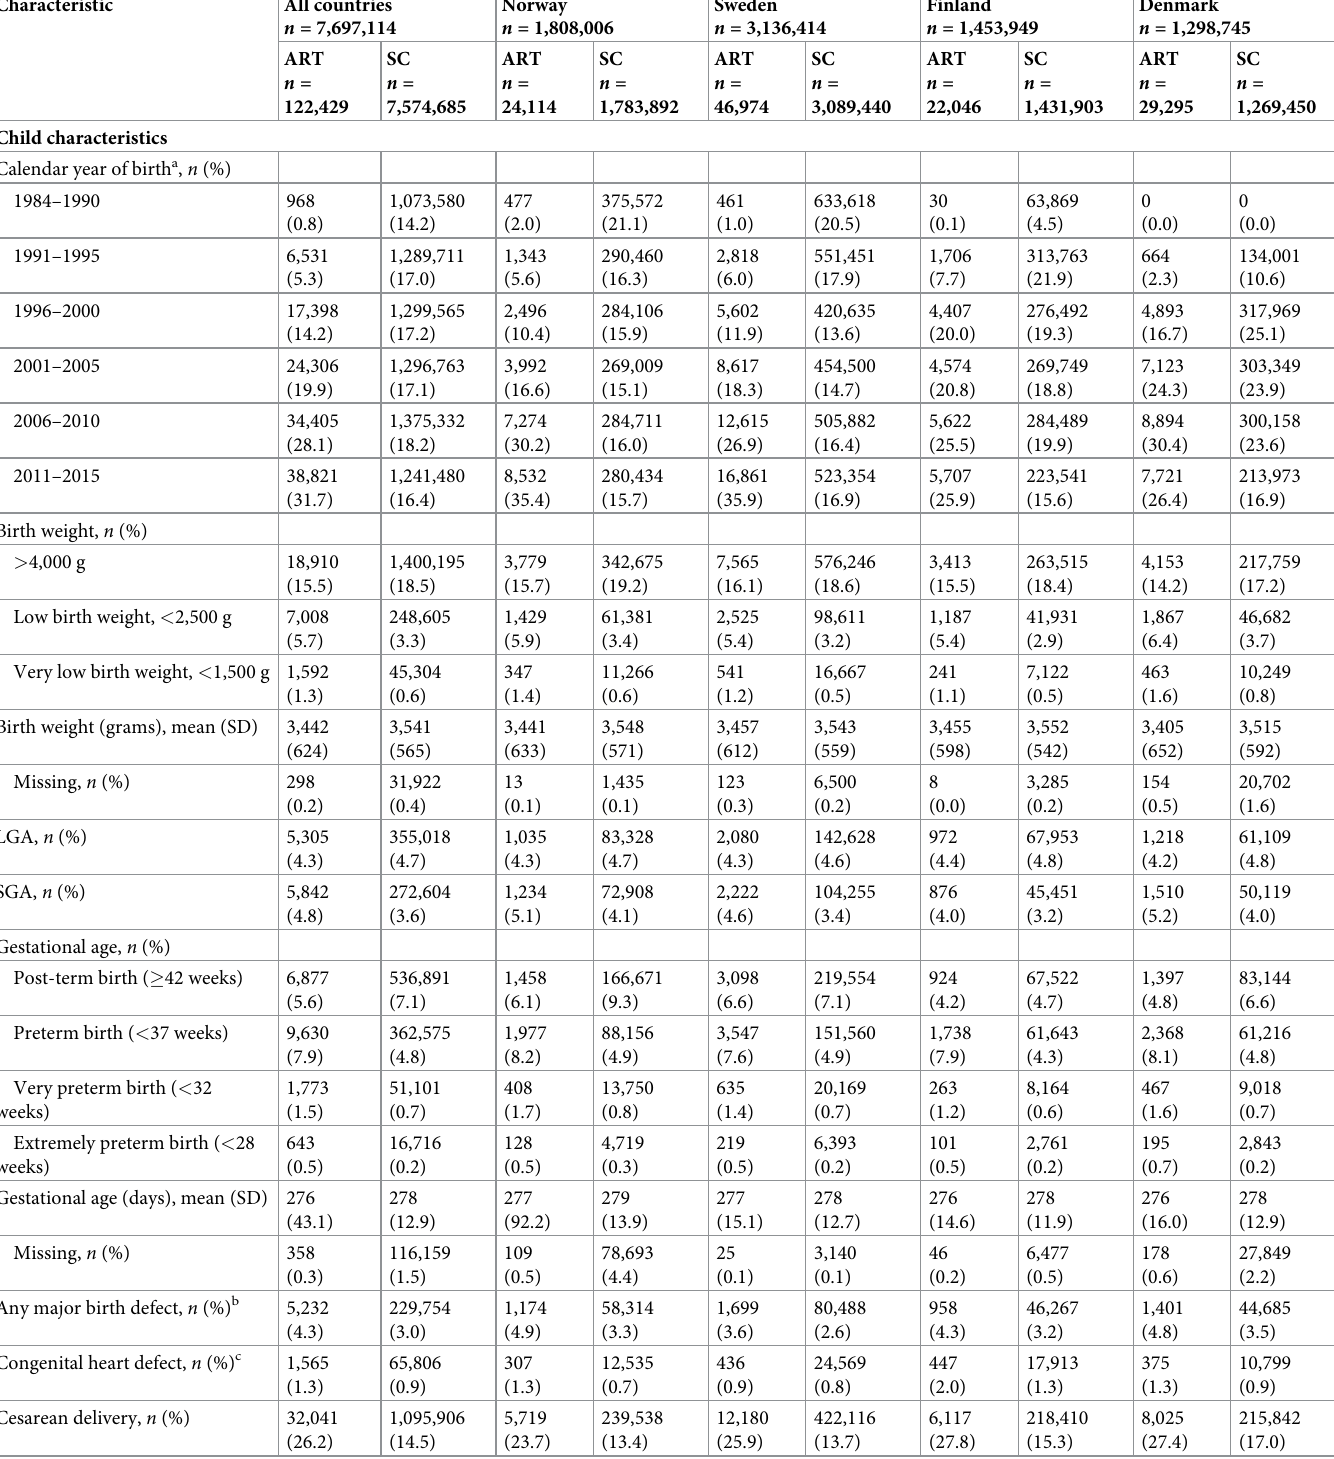
Table 1. Background characteristics of singletons born after ART and spontaneous conception between 1984 to 2015 a in Sweden, Norway, Finland, and Denmark, and their mothers.